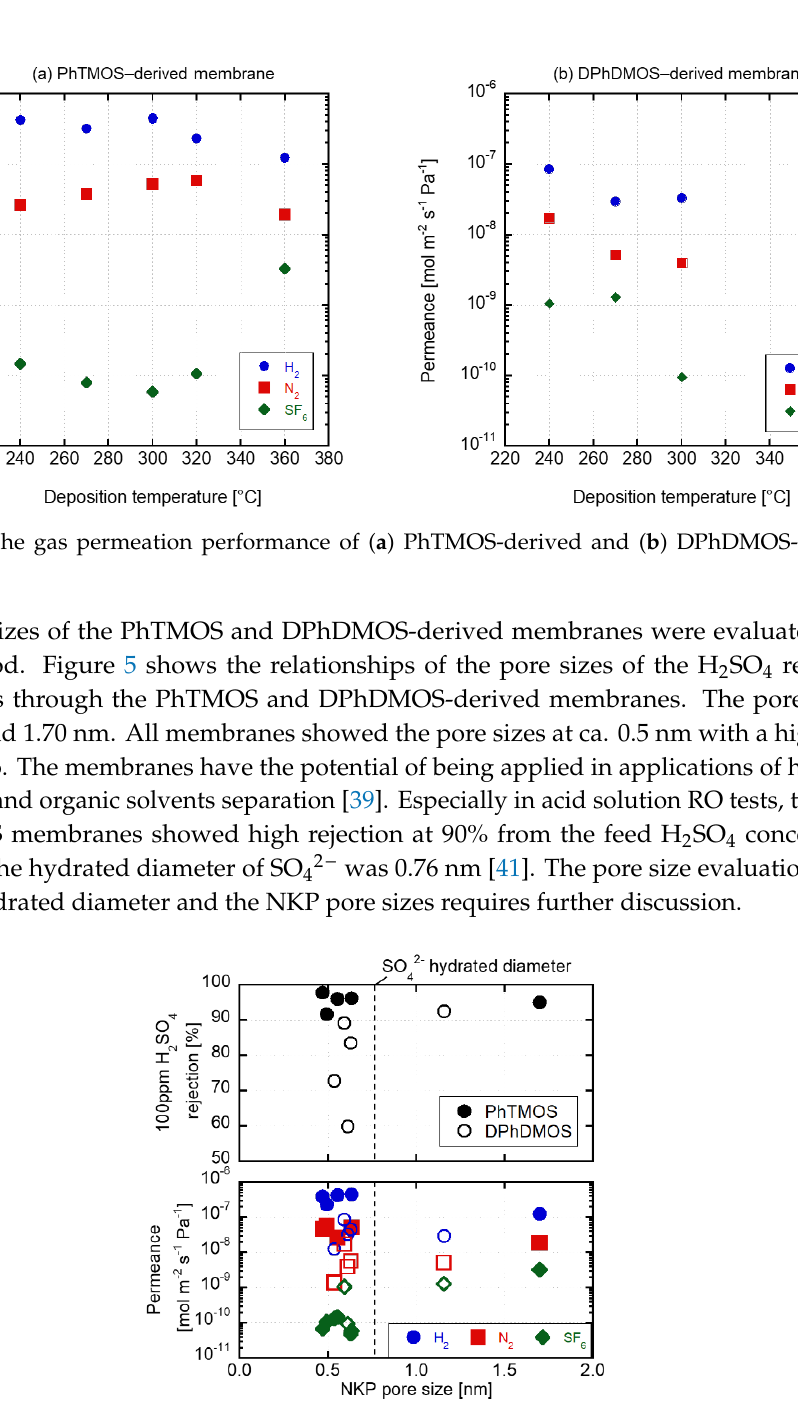
Figure 4. The gas permeation performance of ( a ) PhTMOS-derived and ( b ) DPhDMOS-derived membranes.